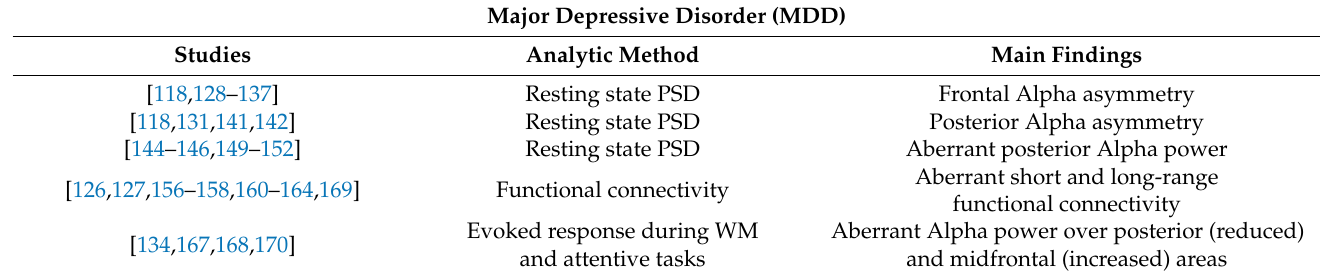
Table 3. Table representing the main electrophysiological findings in the MDD, with the methods and the studies who contributed to